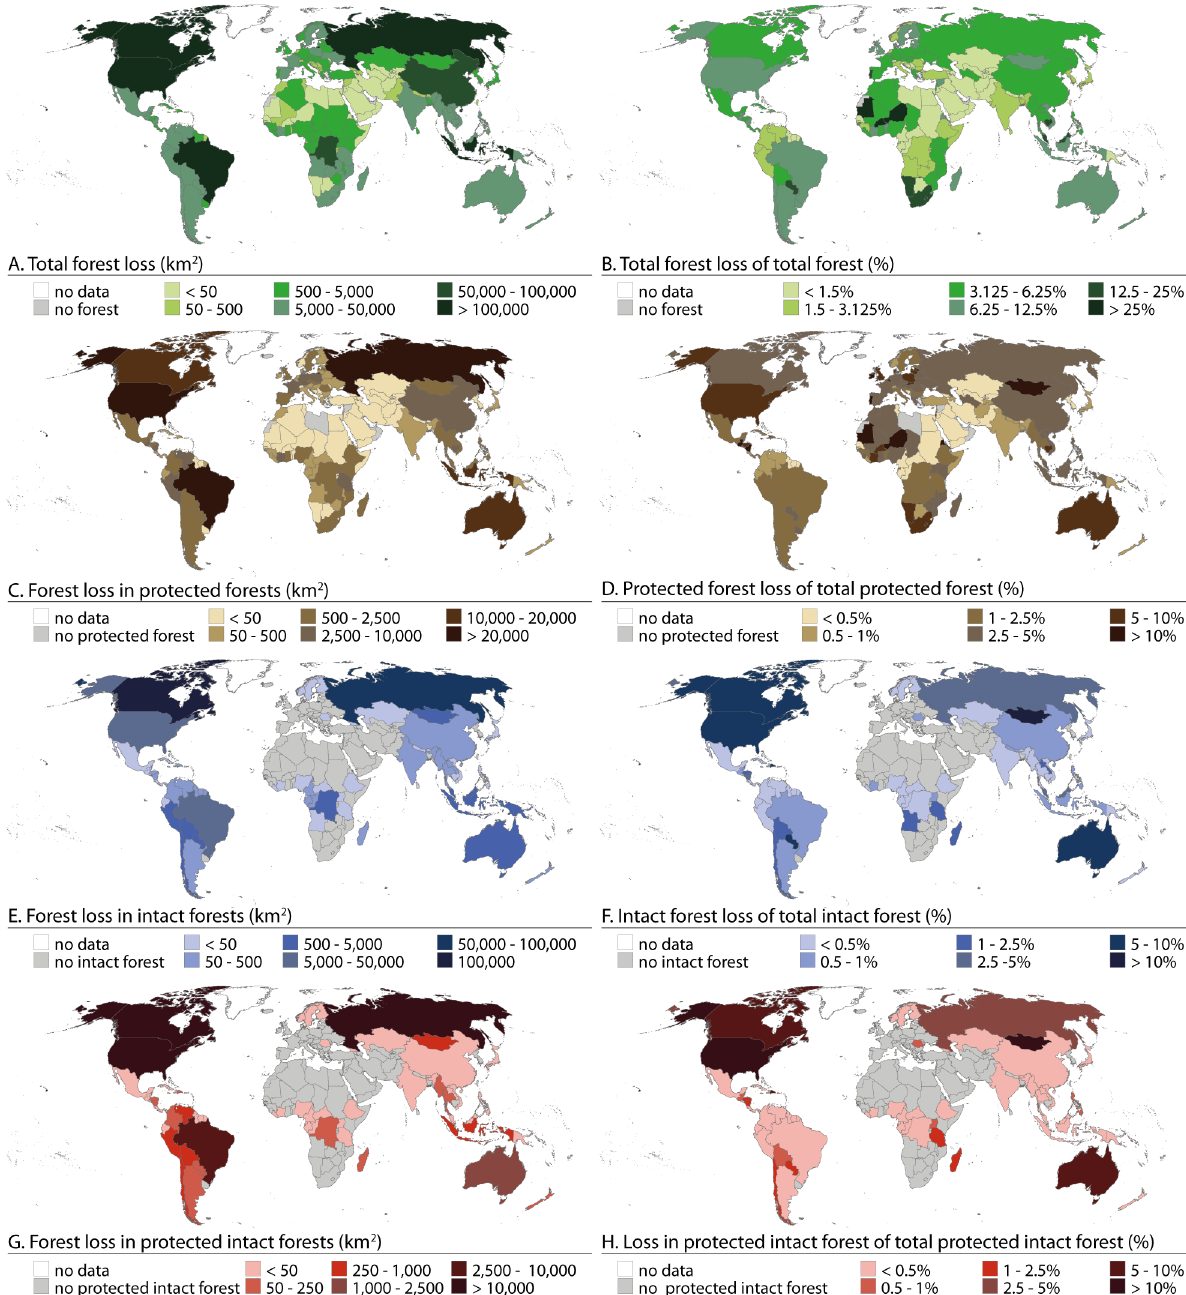
Fig 3. Absolute and relative forest losses by country between 2000 and 2012. Absolute forest losses (left column) are presented in km 2 and relative forest losses (right column) are in %. A and B) Total forest loss; C and D) Loss in protected forests; E and F) Loss in intact forest; G and H) Loss in protected intact